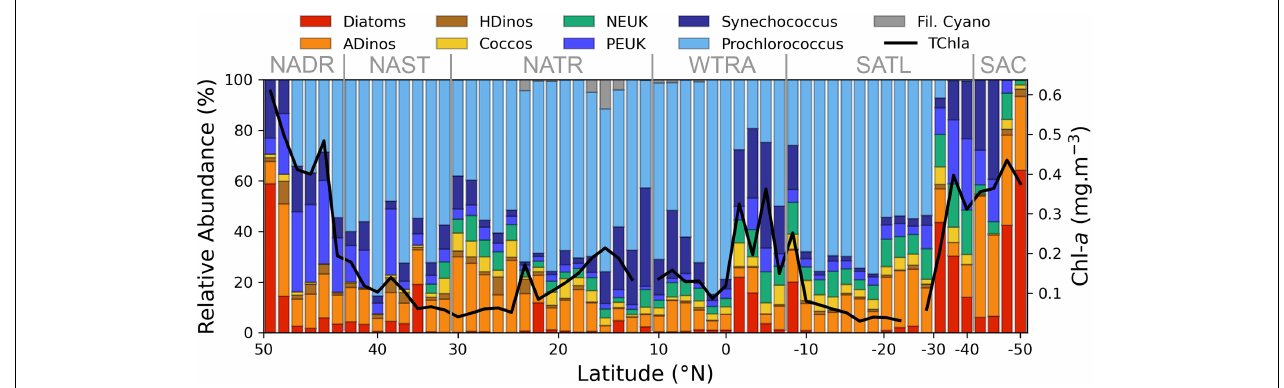
FIGURE 3 | Relative abundance of major phytoplankton groups, enumerated by FC or microscopy and estimated in mg carbon m − 3 , along the AMT transect (N-S), Chl a value is also plotted. The correspondence between groups and size classes is given by the colour code: Picoplankton, blue tones; Nanoplankton, yellow and green; Microplankton, red and brown. Longhurst provinces are indicated. NADR, North Atlantic Drift; NAST, North Atlantic Subtropical Gyre; NATR, North Atlantic Tropical Gyre; WTRA, Western Tropical Atlantic; SATL, South Atlantic Gyre; SAC, South Atlantic